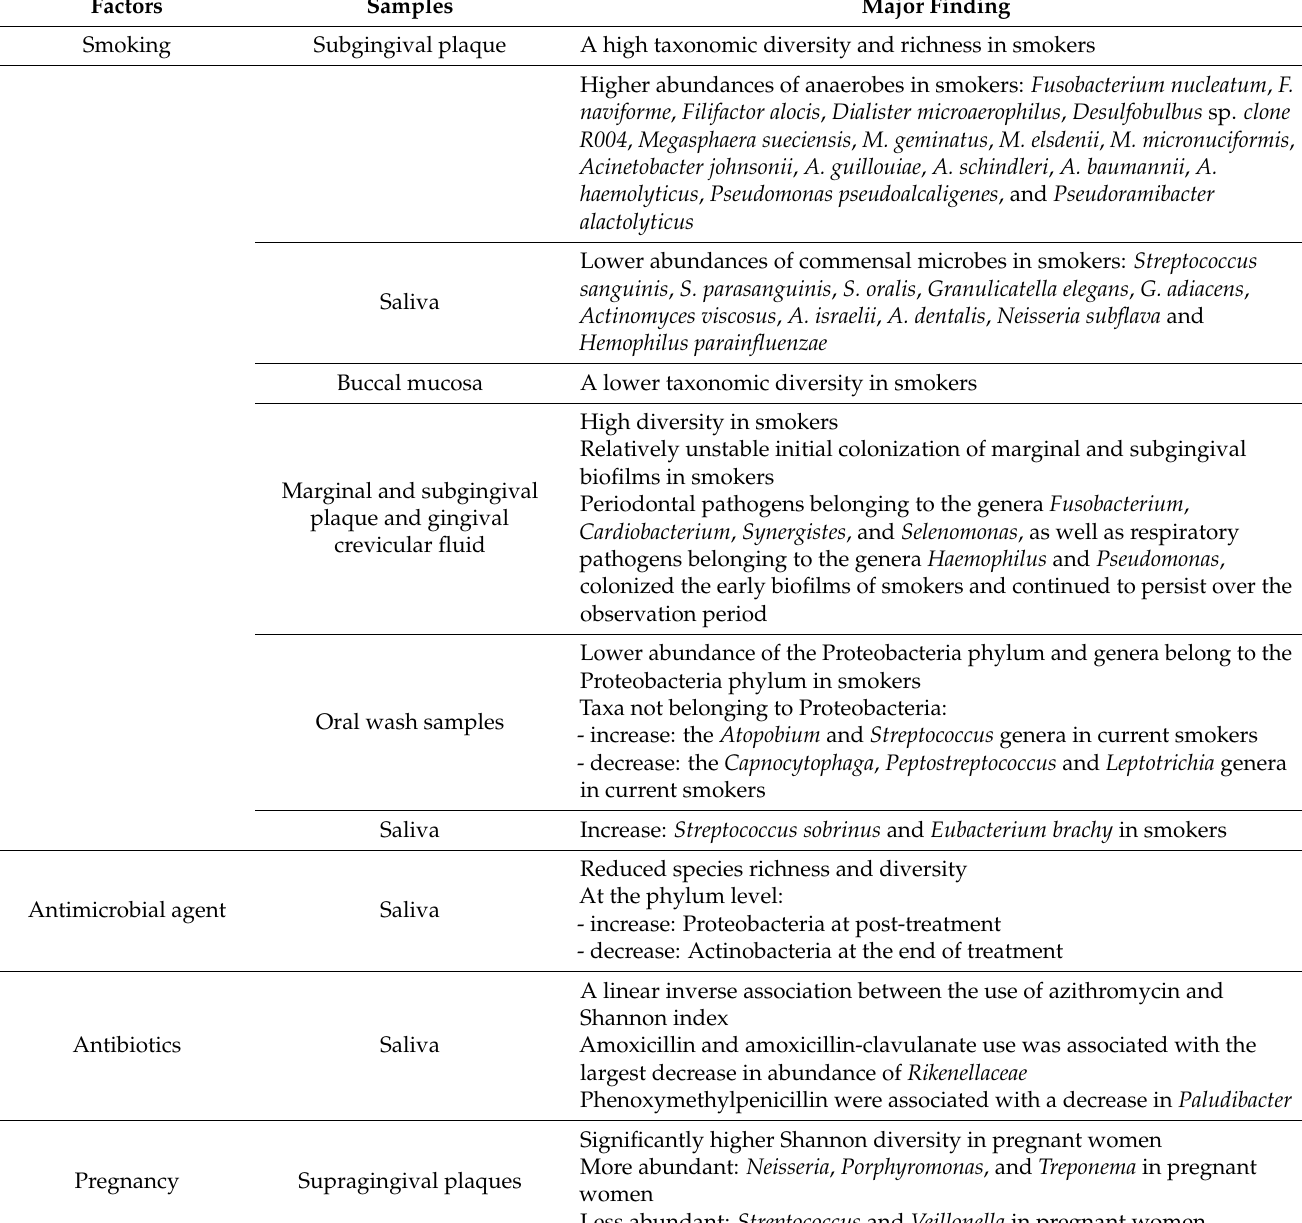
Table 1. Various factors affecting the alteration of oral microbiome composition: analysis using 16S rRNA gene sequencing.